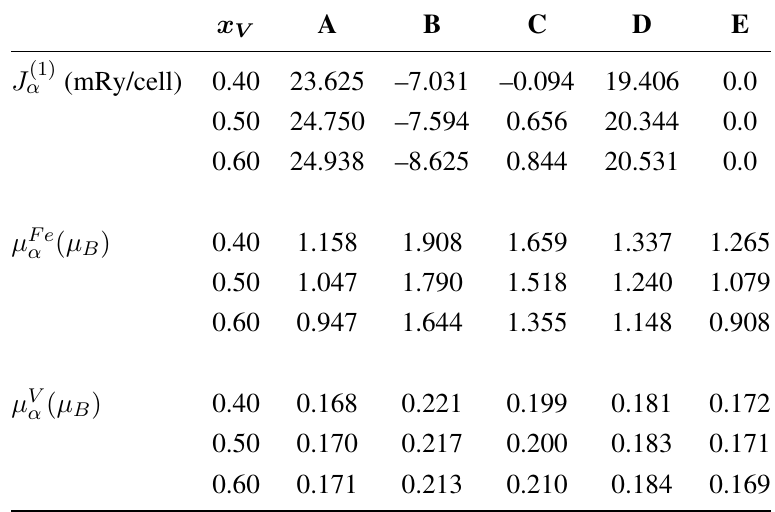
Table 5. On-site parameters J (1) (mRy/cell) and local magnetic moments of Fe and V, α = { 0 . 40; 0 . 50; 0 . 60 } in the Fe-V µ Fe and µ V , calculated for different alloy compositions x V α α system with the corresponding lattice parameters V = { 0 . 37747; 0 . 38319; 0 . 38892 } nm 3 and c/a = { 0 . 518; 0 . 517; 0 . 516 } within the DLM-LSF model at T = 1,000